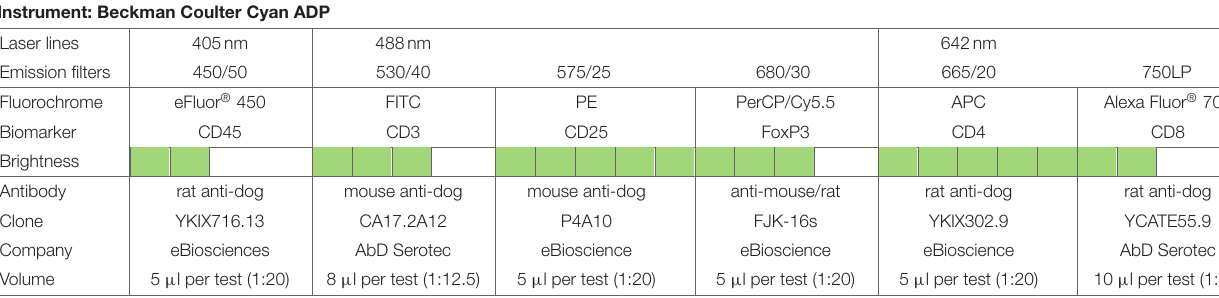
TABLE 1 | Flow cytometer setup, fluorochrome panel, and labeling. Instrument: Beckman Coulter Cyan ADP